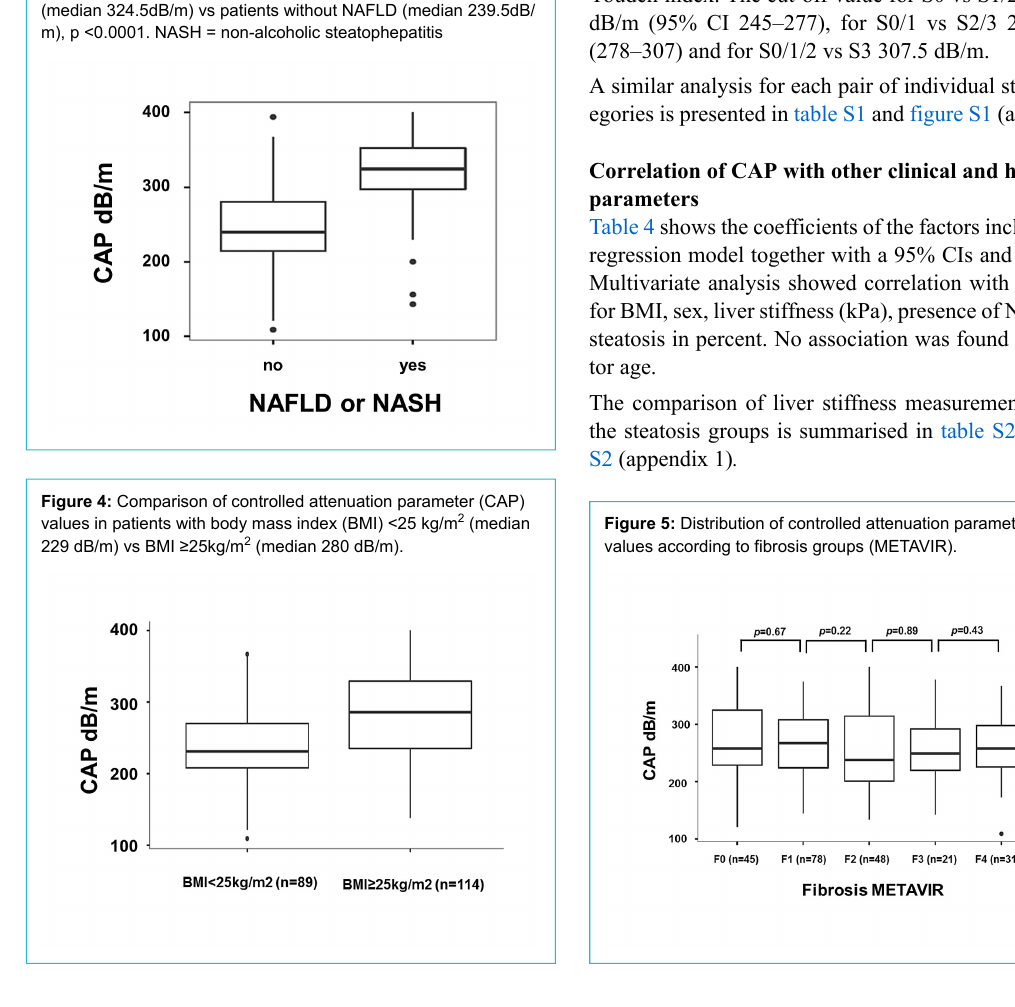
Figure 3: Comparison of controlled attenuation parameter (CAP) values in patients with non-alcoholic fatty liver disease (NAFLD) (median 324.5dB/m) vs patients without NAFLD (median 239.5dB/ m), p <0.0001. NASH = non-alcoholic steatophepatitis